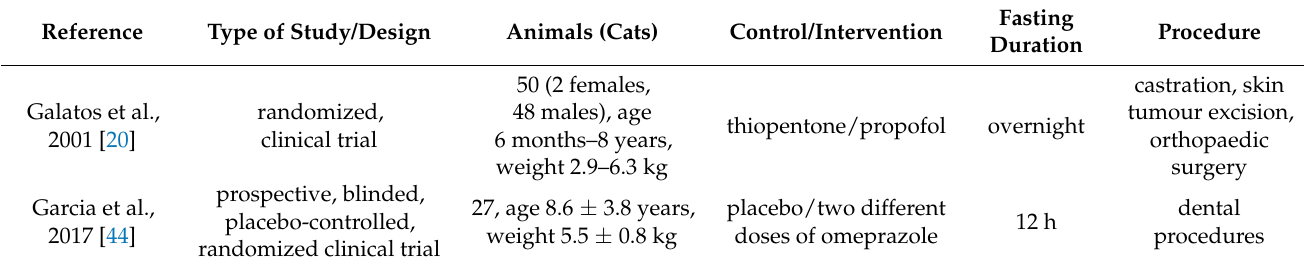
Table 8. Characteristics of the two studies in cats.